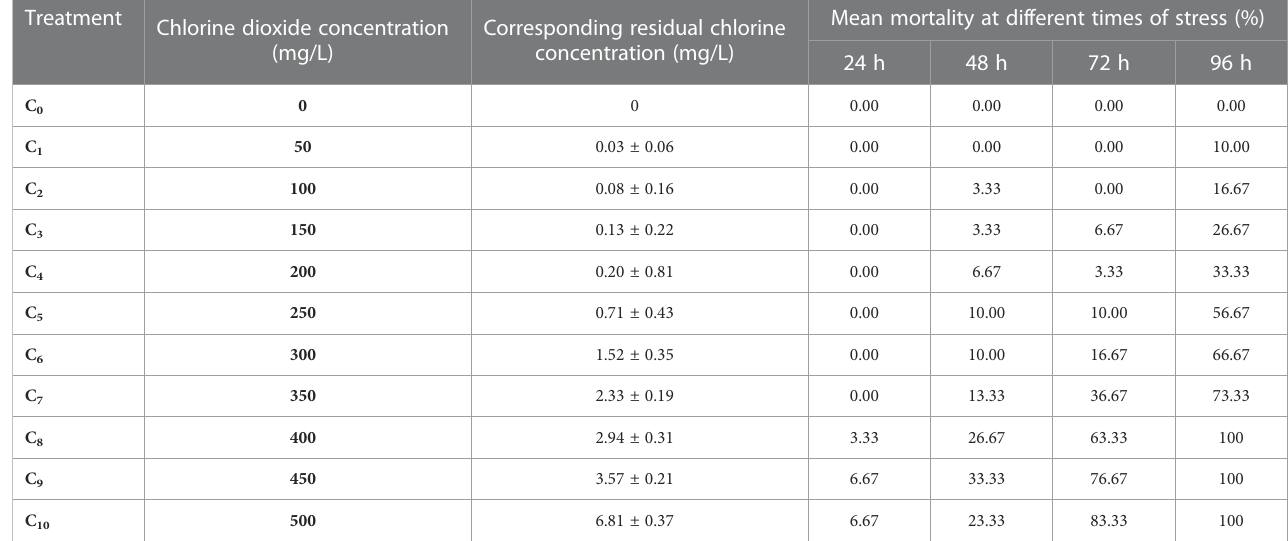
TABLE 2 Experimental results of acute lethal effect of chlorine dioxide on C. sinensis .